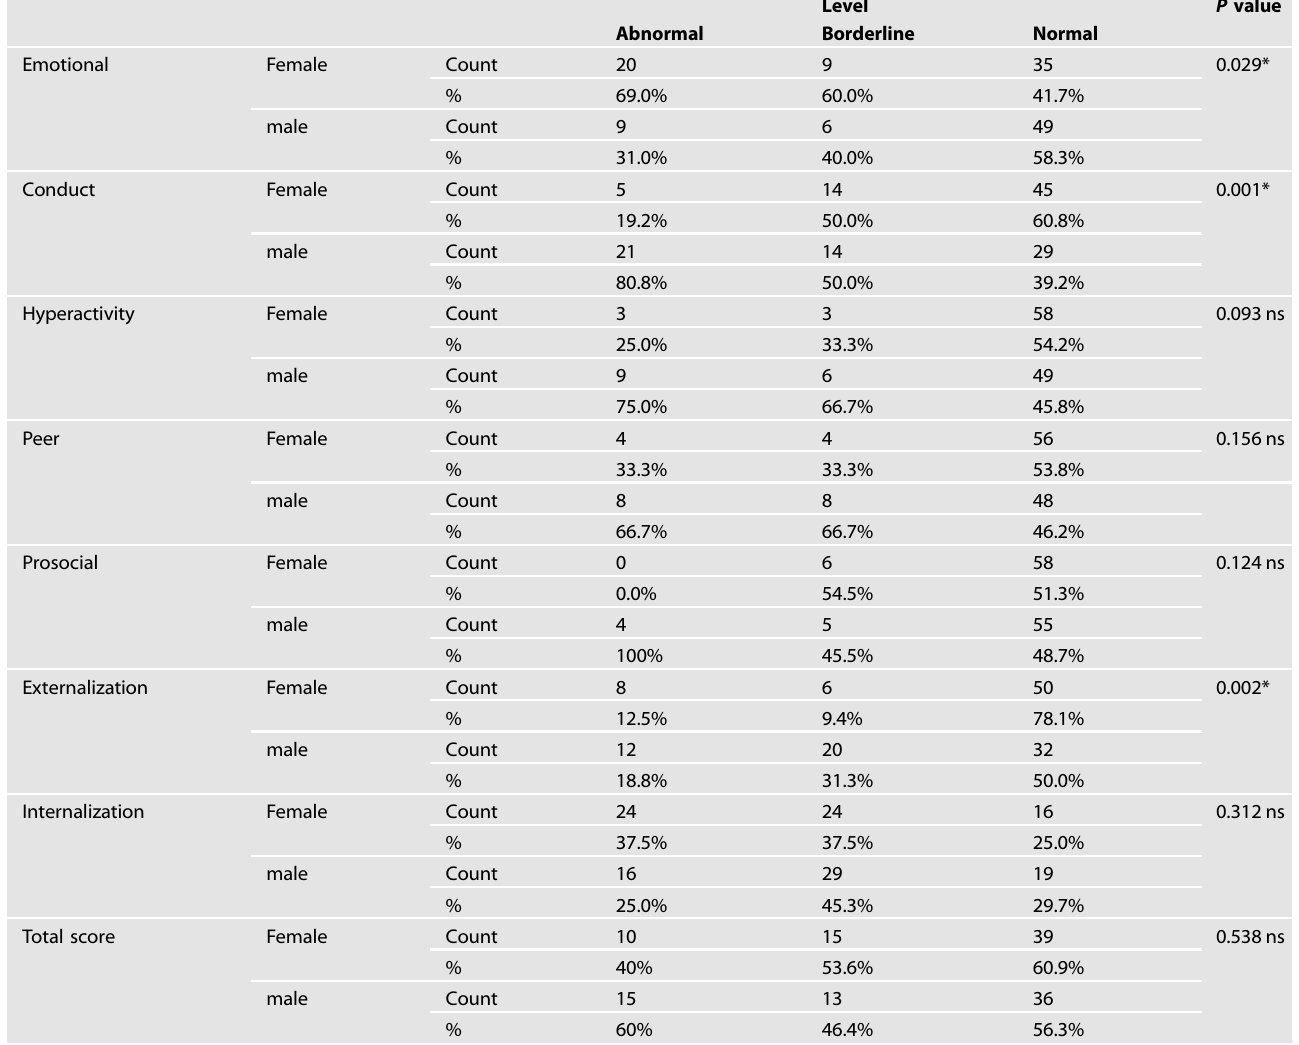
Table 4. Correlation between gender and psychological attributes, internalizing, externalizing, and total dif fi culty